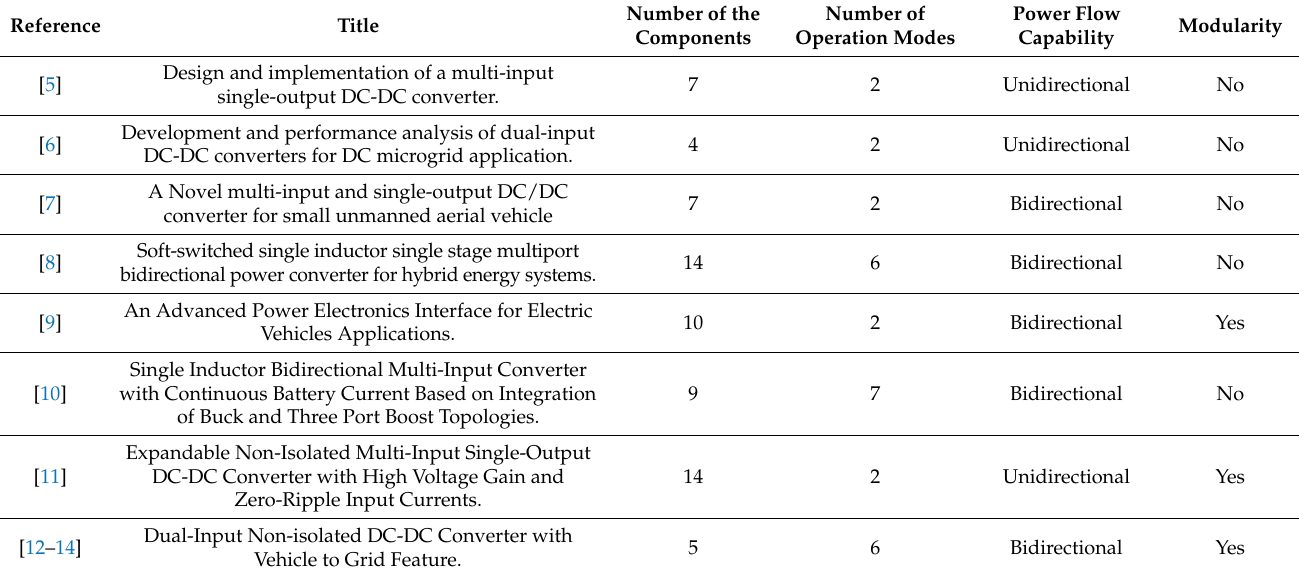
Table 1. Different characteristics of the multi-input DC/DC converters in the literature review.